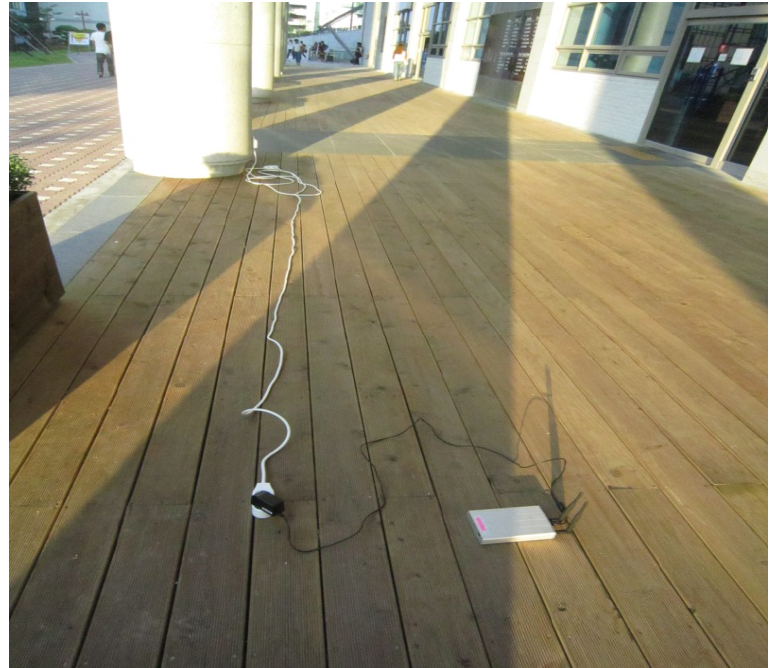
Figure 7. Photo of the actual field test where MP2 is located in between MP1 and MP3.